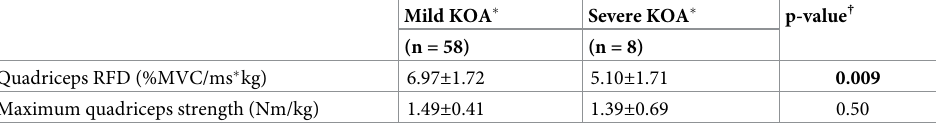
Table 2. Differences between participants with mild and severe KOA in the quadriceps RFD and maximum quad- riceps strength.